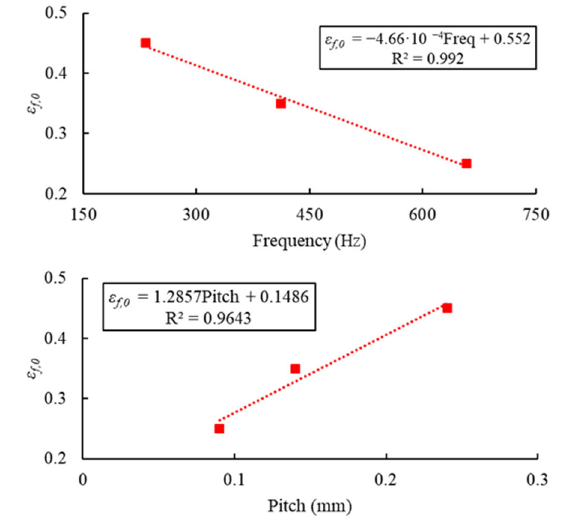
Figure 19 . Variation of segmentation frequency and pitch with ε f,0. Figure 19. Variation of segmentation frequency and pitch with ε f ,0 .